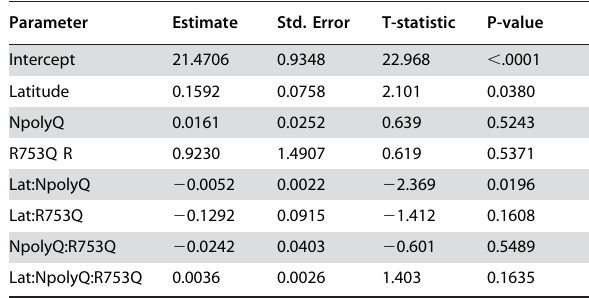
Table 2. Parameter estimates and tests from a multiple linear regression of period length on latitude, wc-1 and frq genotypes; NpolyQ length and FRQ: R753Q, respectively. .. ... .... ... ... .... ... ... .... ... ... .... ... ... .... ... ... .... ... ... .... .